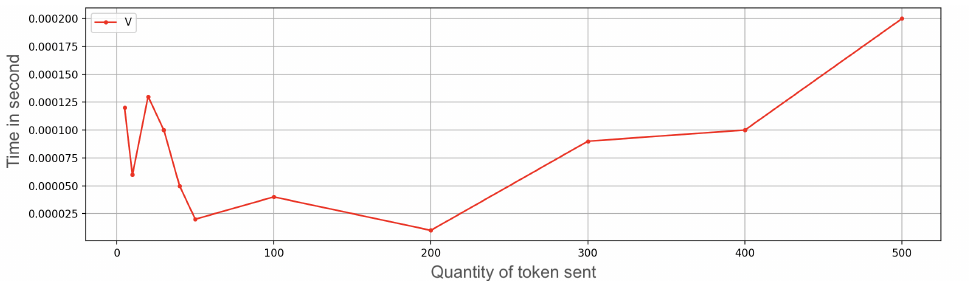
Figure 10. Exchange token time on iPhone 7 without the secure enclave execution measuring variance (V) of the ramp